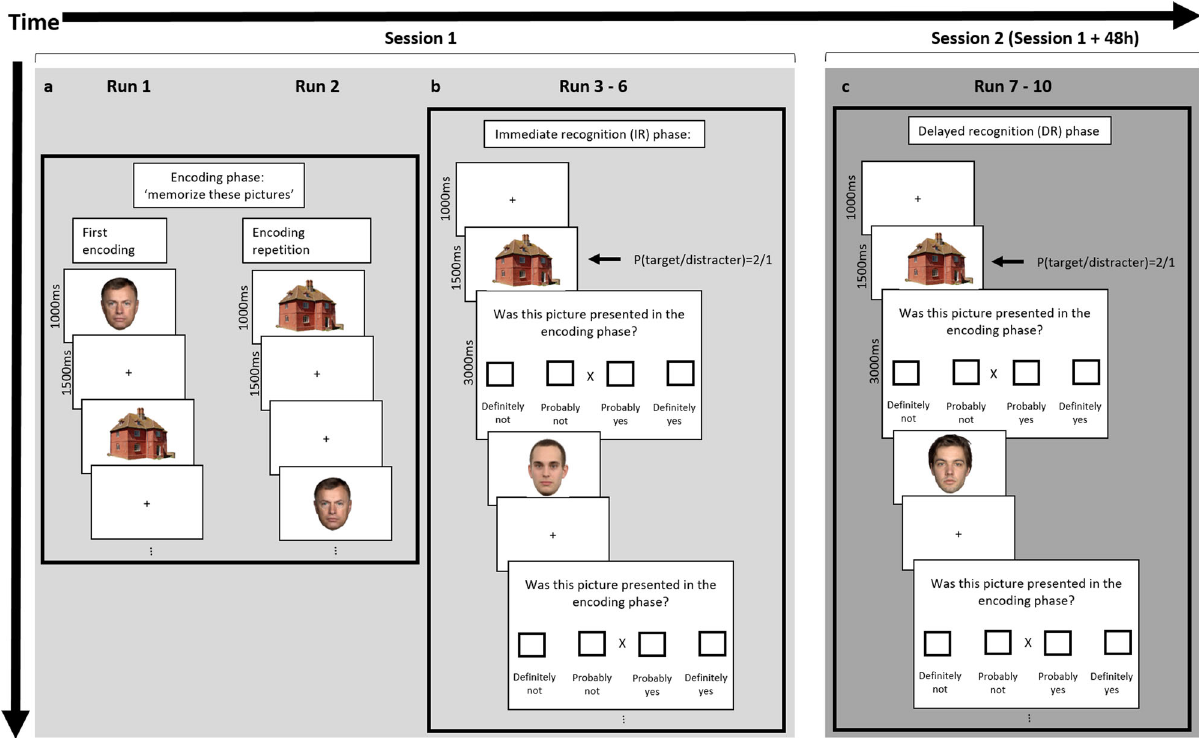
Fig. 1 Schematic design of the protocol. The experiment consisted of an encoding phase, an immediate recognition phase (IR), and a delayed recognition phase (DR), with a total of 10 runs. a The encoding phase consisted of two runs. In each run, 160 stimuli (80 houses and 80 faces) were pseudo-randomly presented for 1000ms with a 1500ms inter-stimulus interval. The second encoding run (encoding repetition) was identical to the fi rst, except for the order of stimulus presentation. Prior to the encoding phase, participants were instructed to memorize the stimuli in order to recognize them in a subsequent recognition test. b The IR phase directly followed the encoding phase. In the IR phase, the stimuli consisted of the 160 stimuli from the encoding phase intermixed with an additional 80 distractors: 40 houses and 40 faces. The trials were equally divided over 4 runs during the IR phase. In the IR, the 1500ms presentation of a stimulus was followed by a 3000ms response screen, which displayed the question “ Was this picture presented in the encoding phase? ” with four boxes below referring to four response alternatives: “ de fi nitely not ” , “ probably not ” , “ probably yes ” , “ de fi nitely yes ” . c The DR phase was conducted two days after the fi rst session (48h). The